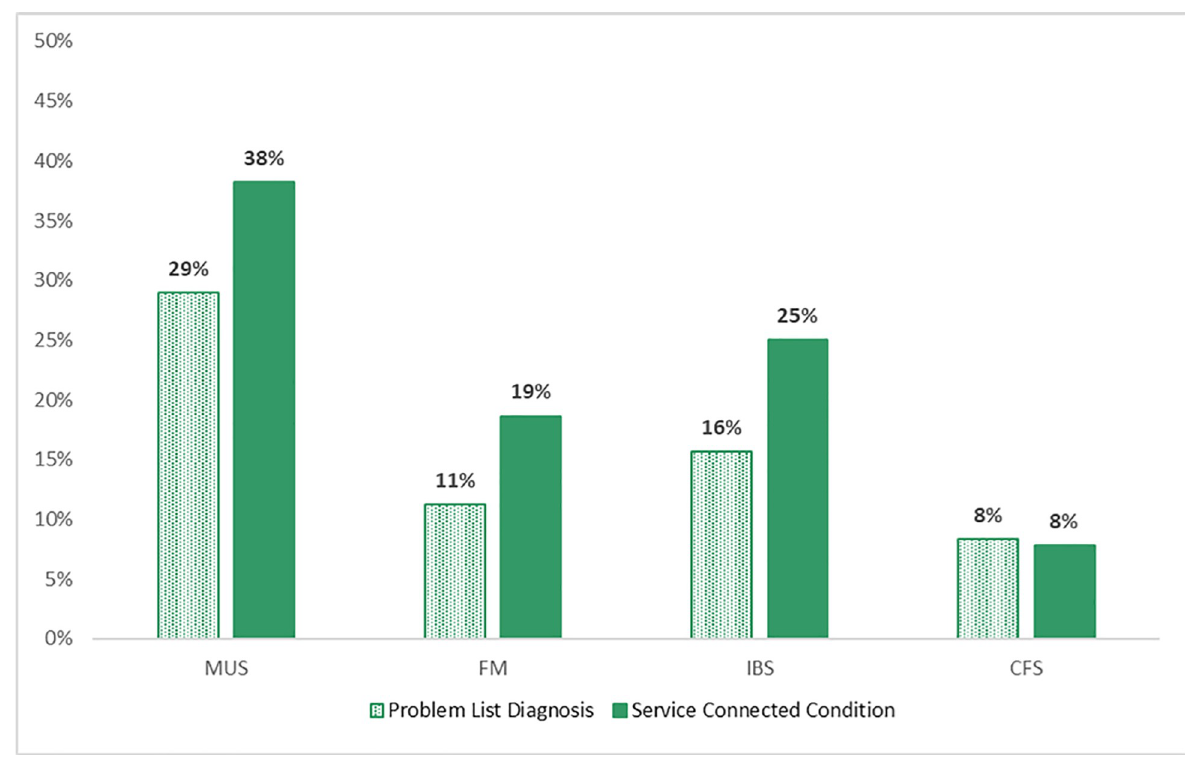
Fig 1. Problem list diagnoses and service-connection for medically unexplained symptoms/conditions. MUS = medically unexplained symptoms/conditions, FM = fibromyalgia, IBS = irritable bowel syndrome or irritable colon, CFS = chronic fatigue syndrome.